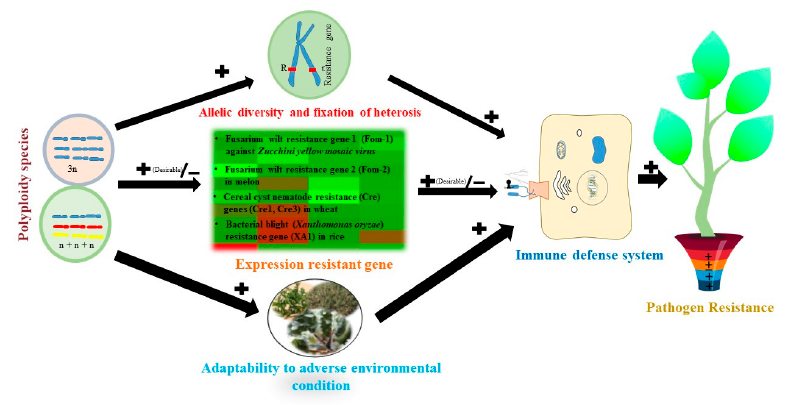
Figure 7. Effect of polyploidy on pathogen resistance. The sign next to the arrow gives the direction of the effect. The sign “+” means the higher ploidy level increases the probability of effects, while “ − ” means the higher ploidy level decreases the probability of effects. Pot represents the combined effect of the polyploidy plant. The gene-for-gene model is the general mechanism of pathogen re- sistance. In the polyploidy host, high allelic diversity with dominant allele, fixed heterosis, and high expression (desirable) of resistance gene directly influence the pathogen resistance. The validated disease resistance genes and their target pathogens are given as examples [54]. The effects of ploidy- level variation on host adaptability under diverse environmental conditions (biotic and abiotic stress) could indirectly influence parasite resistance.